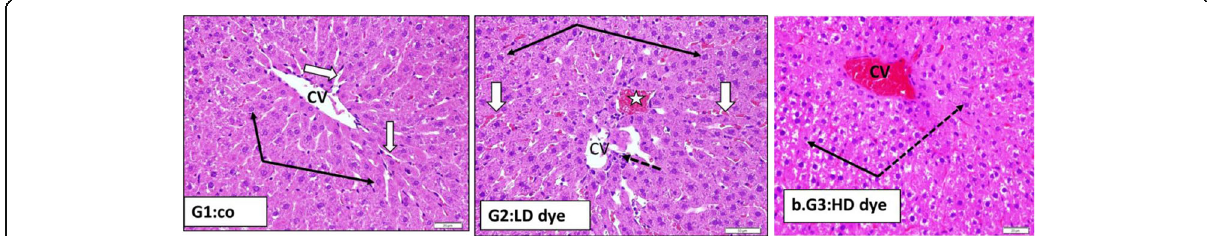
Fig. 2 Sections in the rat liver central vein region (CV) show the following: G1: CO (control) group with normal hepatocyte cell cords (black arrows) and thin intervening sinusoids (white arrows) (H-E, ×200). G2: LD dye (low dose) showing mild granularity of hepatocytes and nuclei with dark stained dense chromatin (black arrows), sinusoidal congestion (white arrows), and focal hemorrhage (star). Central vein (CV) showed endothelial lining damage (dotted arrow) (H-E, ×200). G3: HD dye (high dose) with marked central vein (CV) congestion and vacuolar degeneration of nearby hepatocytes (arrows), swollen sinusoids that could not be seen. Others on the right are darkly stained shrunken and degenerated (dotted arrows) (H-E,